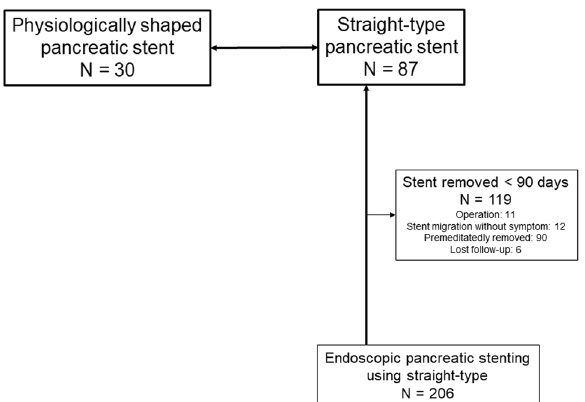
Figure 4. Flow diagram of the study. We collected 30 patients who received an 8.5 Fr physiologically shaped pancreatic stent. For comparison, we extracted the information of 87 patients who had a straight-type pancreatic stent for ≥ 90 days. Fr,